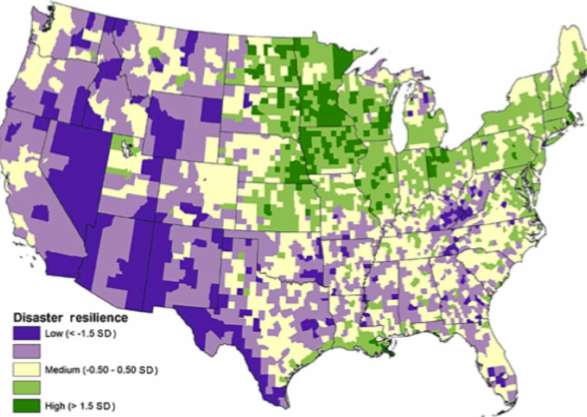
Figure 3. Disaster resilience value in USA (Cutter et al.,